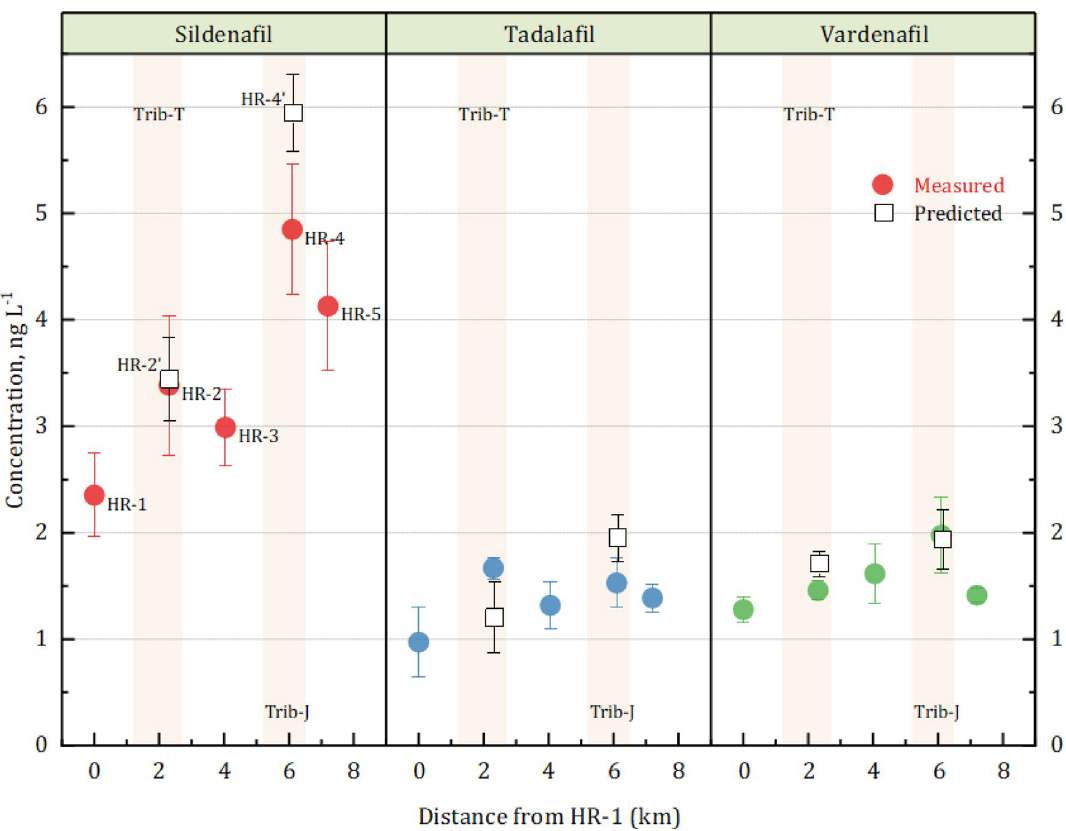
Figure 5. PDE-5i concentrations of water samples collected along Han River; HR-1 (utmost upstream) to HR-5 (utmost